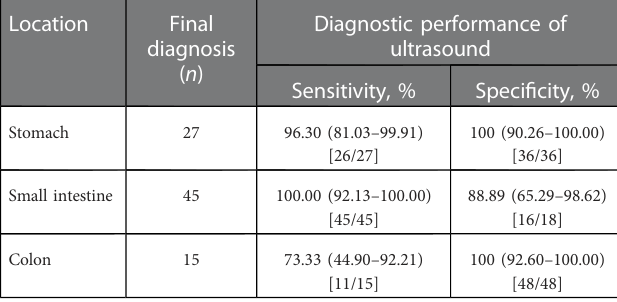
TABLE 3 Diagnostic performance of location indicated by ultrasound of 63